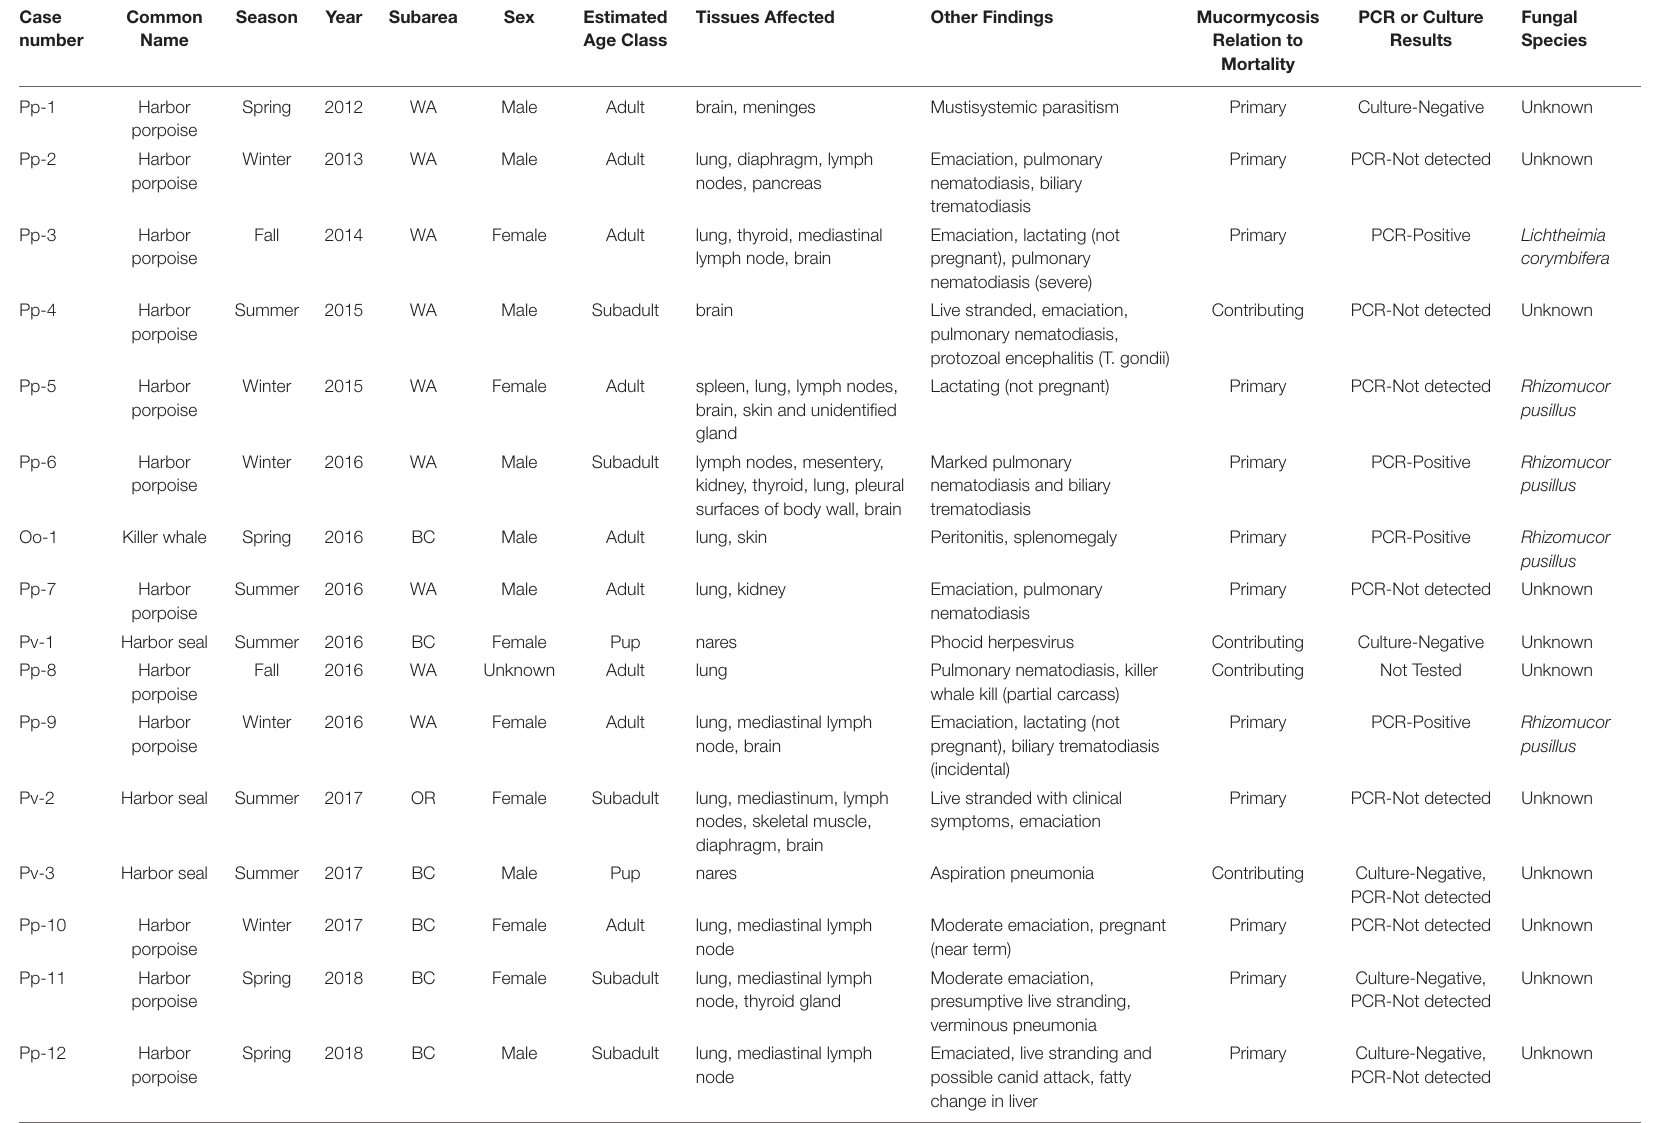
TABLE 2 | Details of mucormycosis cases found in the Pacific Northwest, 2012–2019, in order of